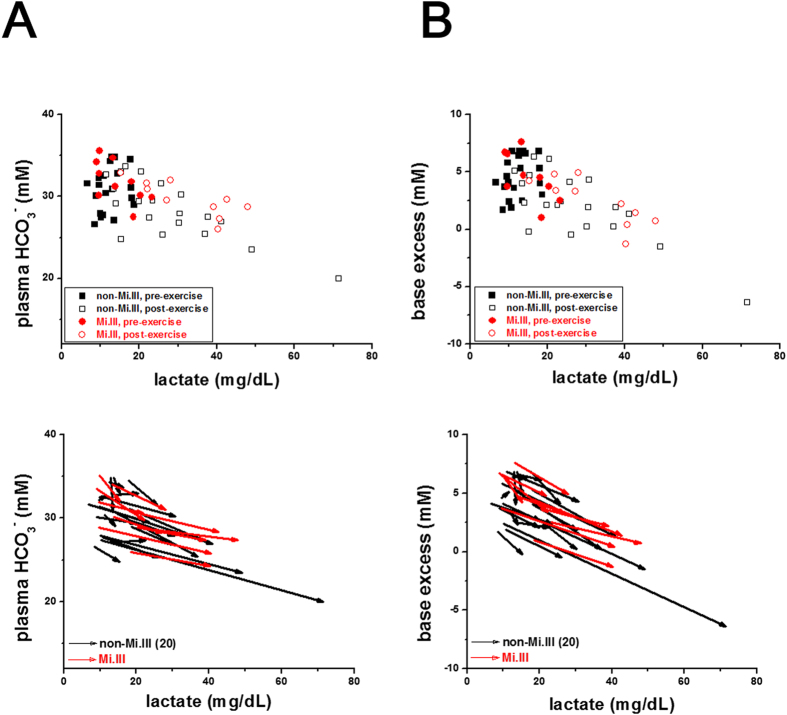
Mi.III and non-Mi.III people showed similar degrees of lactate production and base buffering following the exercise challenge.(A) roughly inverse correlation between plasma lactate and bicarbonate levels for all subjects before and after exercise. (B) A similar, inverse correlation between plasma lactate and base excess. Top: The concentrations immediately before 3-minute exercise (shown in solid symbols) and after exercise (in empty symbols) were plotted for individual Mi.III (red) and non-Mi.III (black) subjects. Bottom: The pre-exercise and the post-exercise data points per subject were connected and represented by a vector.